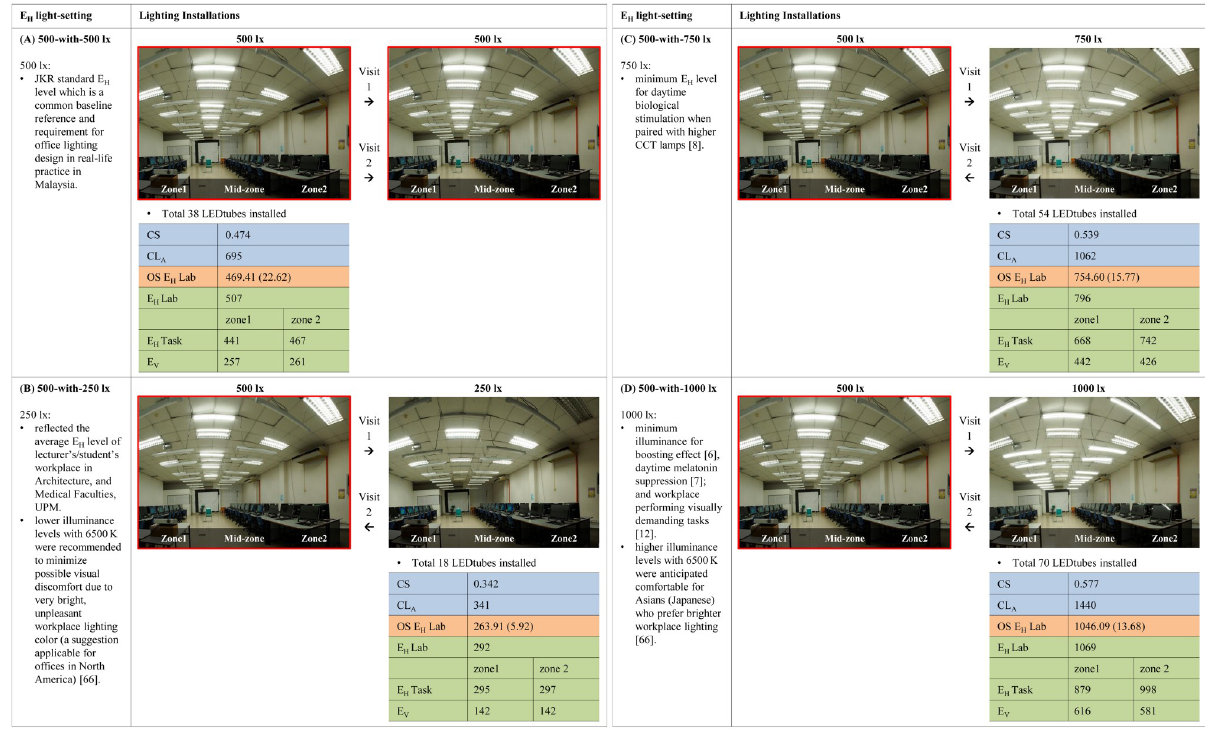
Fig 3. Lighting installation and characteristics of each E H light-setting. (A) 500-with-500 lx. (B) 500-with-250 lx. (C) 500-with-750 lx. (D) 500-with- 1000 lx. Public Works Department Malaysia (JKR), Red border indicates similar OS E H Lab levels. Blue shaded values are the Circadian Stimulus Estimation, estimated with CS metric calculator: Circadian Stimulus value (CS), Circadian Light (CL A ) circadian lx. Light orange shaded values are the On-Site Measurement performed during each experimental session with the 13 monitors switched on, measured with luxmeter: Mean (SD) horizontal illuminance at 0.755 m from FFL in the mid-zone area (OS E H Lab) lx. Green shaded values are the DIALux Simulated Model Estimation, estimated with DIALux: Average horizontal illuminance at 0.755 m from FFL in the mid-zone area (E H Lab) lx, Average horizontal illuminance at 0.755 m from FFL at Zone1 and Zone2 (E H Task) lx, Average vertical illuminance at 1.105 m from FFL at Zone1 and Zone2 (E V ) lx.